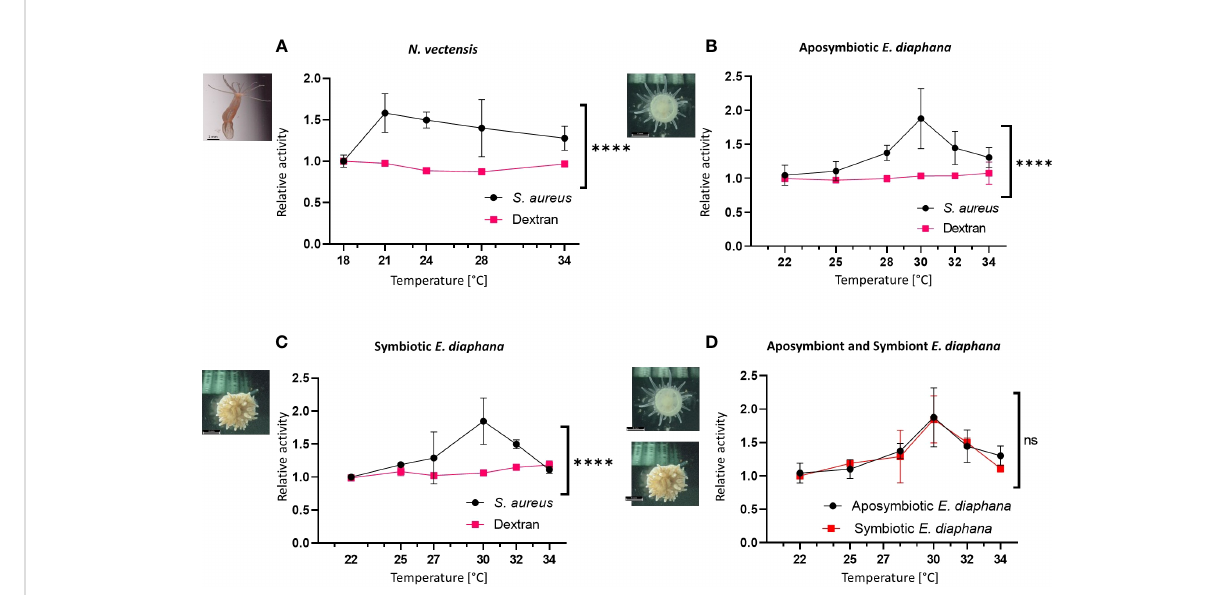
FIGURE 4 Immune activation vs pinocytosis at increased temperatures in hexacorallian models. (A) The relative change in the fl ow cytometry percentage of activity in the N. vectensis phagocytic cells (normalized to ambient temperature) signi fi cantly elevated with heat, compared to the control pinocytosis of dextran. (B, C) The relative change in the fl ow cytometry percentage of activity in the aposymbiotic E. diaphana (B) and symbiotic E. diaphana (C) phagocytic cells (normalized to ambient temperature) signi fi cantly elevated with heat, compared to the control pinocytosis of dextran. (D) The relative percentage change in different temperatures of the S. aureus phagocytosis in the aposymbiotic and the symbiotic E. diaphana phagocytic cell is similar. Control temperature for the N. vectensis model is 18°C and 22°C is the control temperature for the E. diaphana models. Mixed effects analysis was performed on the phagocytosis and the pinocytosis series for each animal model (A – C) , and between the two E. diaphana models (D) . Mixed effects analysis, using the model of restricted maximum likelihood method (REML; detailed in Supplementary Table 1). P-value between treatments: ns, Not signi fi cant, ****: p < 0.0005. Scale bar represents